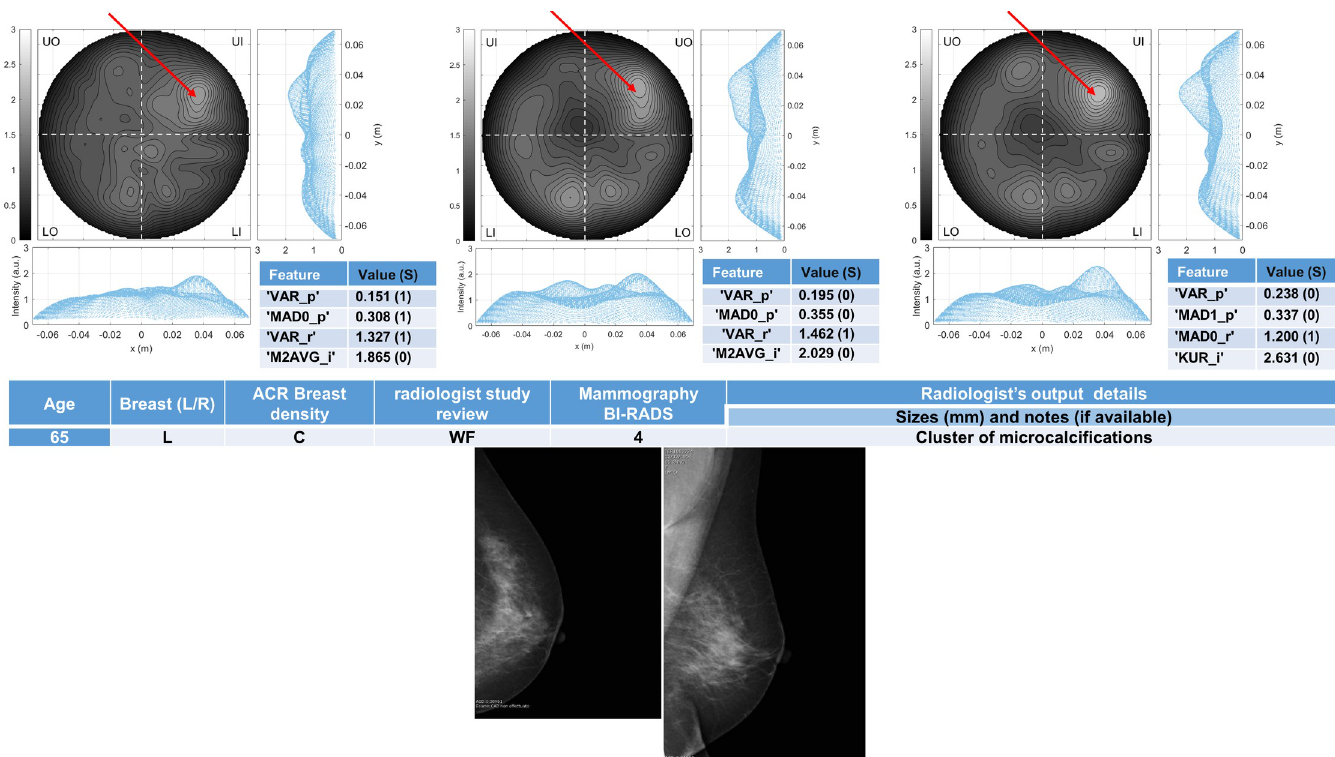
Fig 6. The radiologist study review “WF” for this heterogeneously dense (ACR C) breast has been obtained with the support of mammography images given in the bottom row, giving as output the presence of a cluster of microcalcifications. The Mammography is BI-RADS 4. The final assessment is benign lesion. Microwave images, normalized to unitary average of the intensity, are given in the top row for three different conductivity weighting (from left to right: 0.3 S/m, 0.4 S/m and 0.5 S/m, respectively). X and Y are given in meters; intensity is in arbitrary units. All microwave images show a non-homogeneous behavior, with a main peak indicated by the red arrows. From the binary score S (given in the inserted tables) we note that the number of occurrences of “1” is three when σ = 0.3 S/m, one when σ = 0.4 S/m and one when σ = 0.5 S/m. The proposed rule-of-thumb classifies this breast as positive.